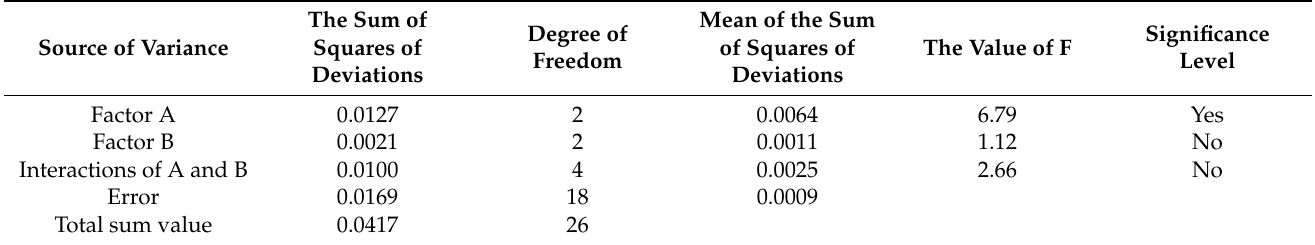
Table 13. Analysis of variance of adhesion strength test of frozen ice on silicone rubber